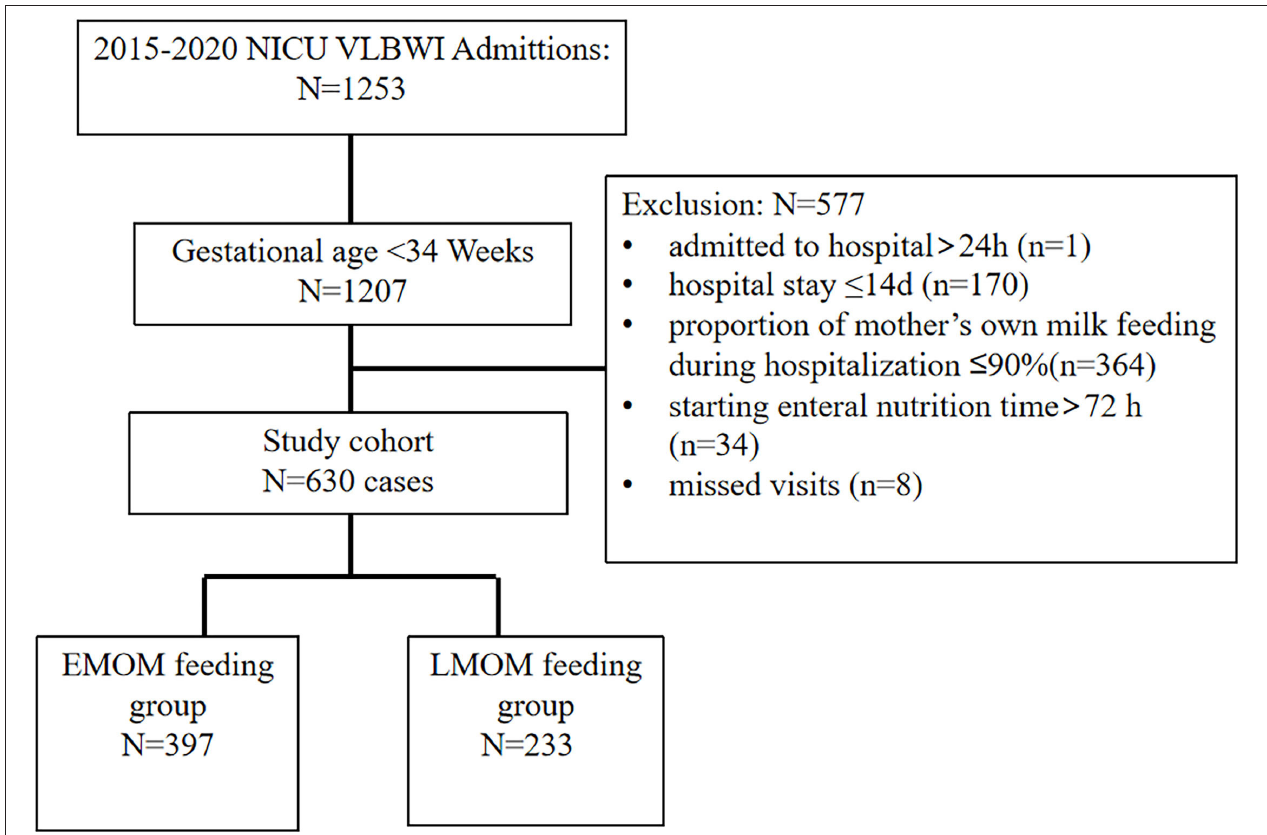
FIGURE 1 | Flowchart of infants included in this study. VLBWI, very low birth weight